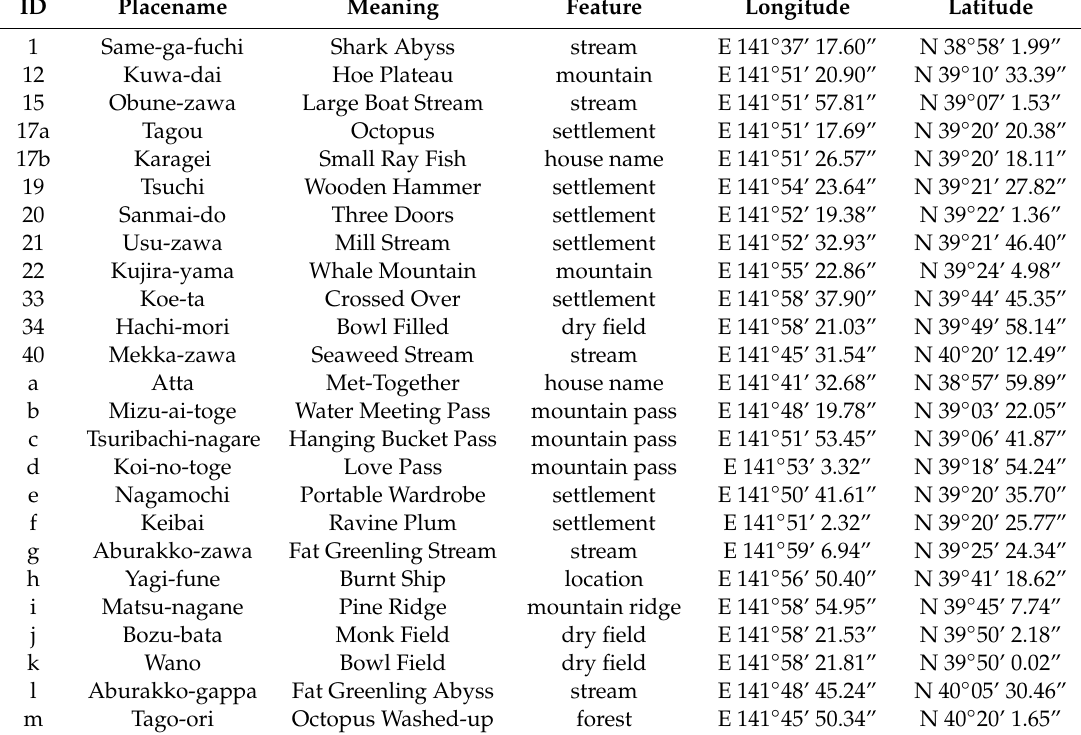
Table 1. List of tsunami-originated placenames. IDs 1~40 are placenames in [38] and IDs a~m are those identified during fieldwork for [39]. Longitudes and latitudes are on the WGS 1984